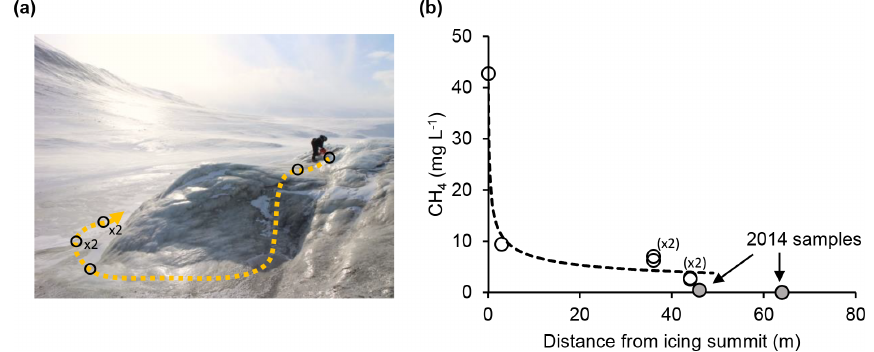
Figure 5. Rapid decrease in dissolved methane concentration with distance from the source of a sub-permafrost groundwater outburst at Innerhytte Pingo summit in April